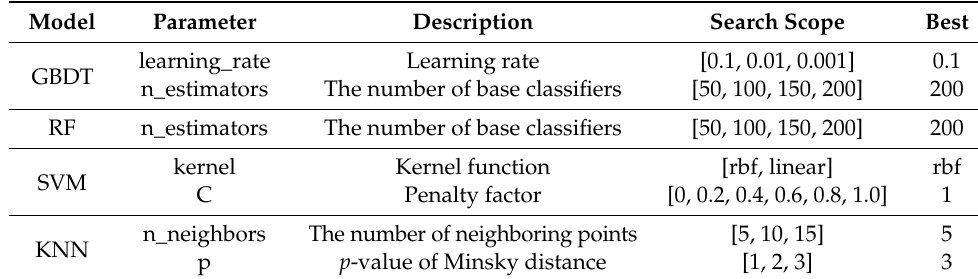
Table 6. Parameter tuning details of machine learning models (GBDT, RF, SVM, and KNN).